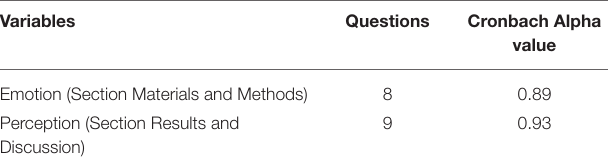
TABLE 4 | Cronbach Alpha test in this study for the questionnaire Sections Materials and Methods and Results and Discussion.